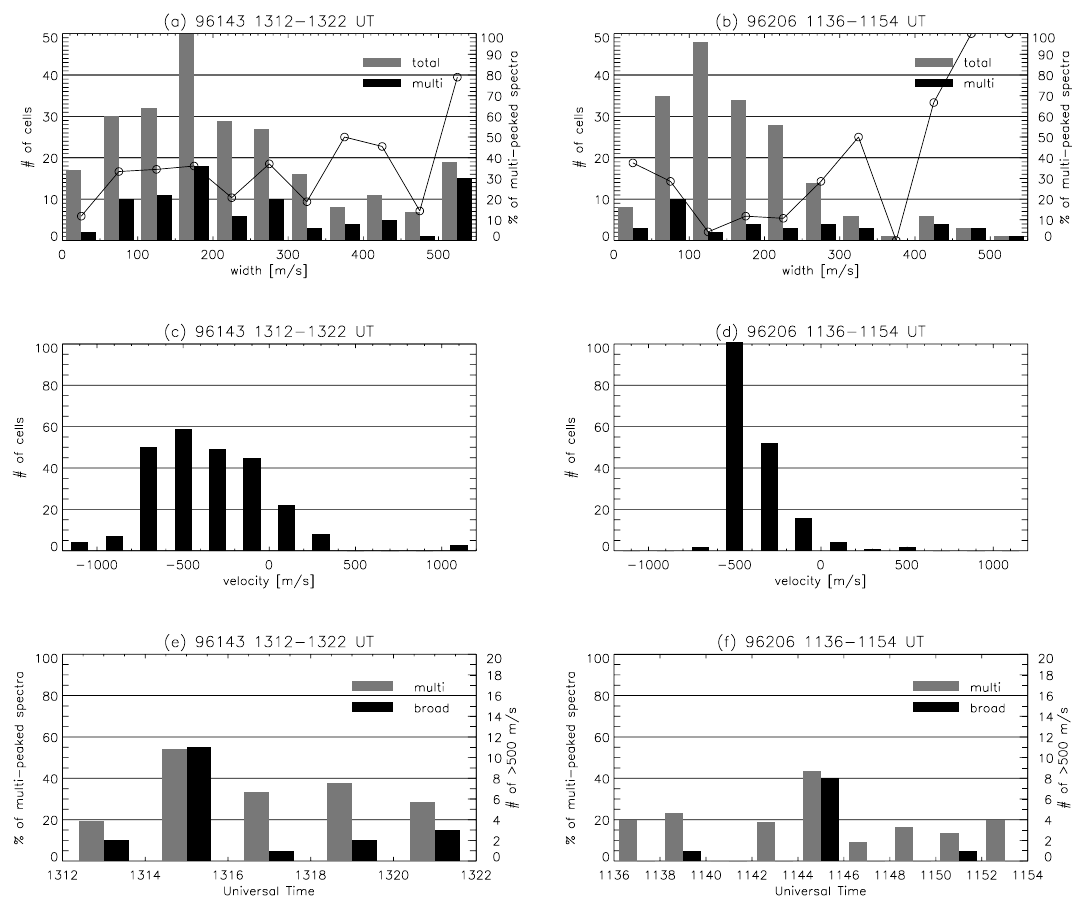
Fig. 3. Histograms of the number of beam-range cells for spectral width (a, b) , Doppler line-of-sight velocity within the TCV-related backscatter region (c, d) , and multi-peaked spectral events and extremely broad spectral width events (e, f) . Percentages of the multi-peaked spectra are superposed with solid lines and circles in the top panels. Sample duration is 13:12–13:22UT for the 22 May event, and 11:36– 11:54UT for the 24 July event,